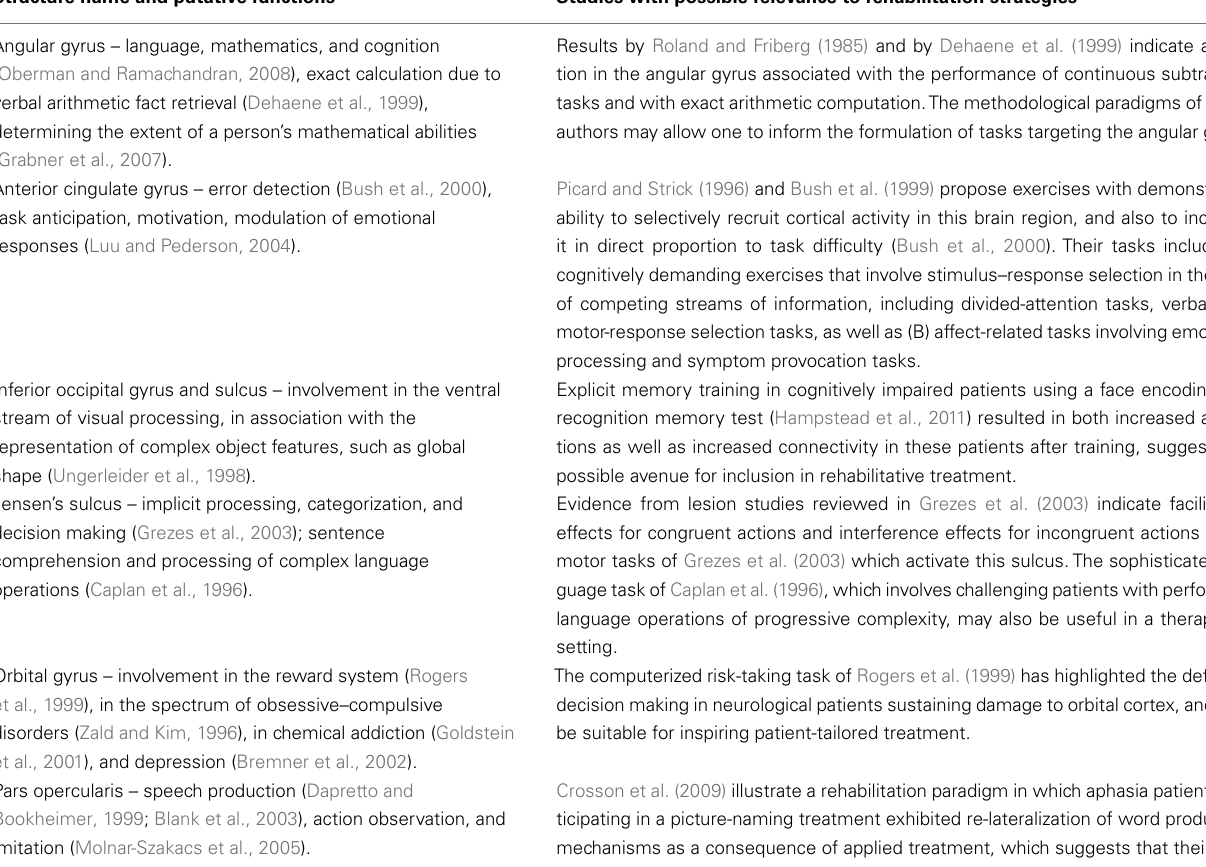
Table 1 | Sample selection of cortical regions affected in at least one of the threeTBI patients.The first column contains the functional description of each region, while the second column indicates paradigms with possible relevance to rehabilitation